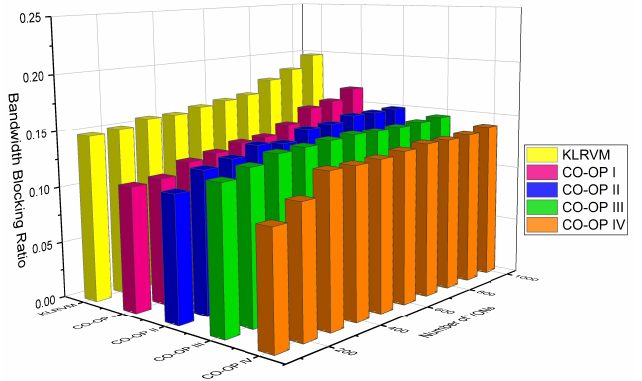
Figure 6. BBR for the NSFNET topology.